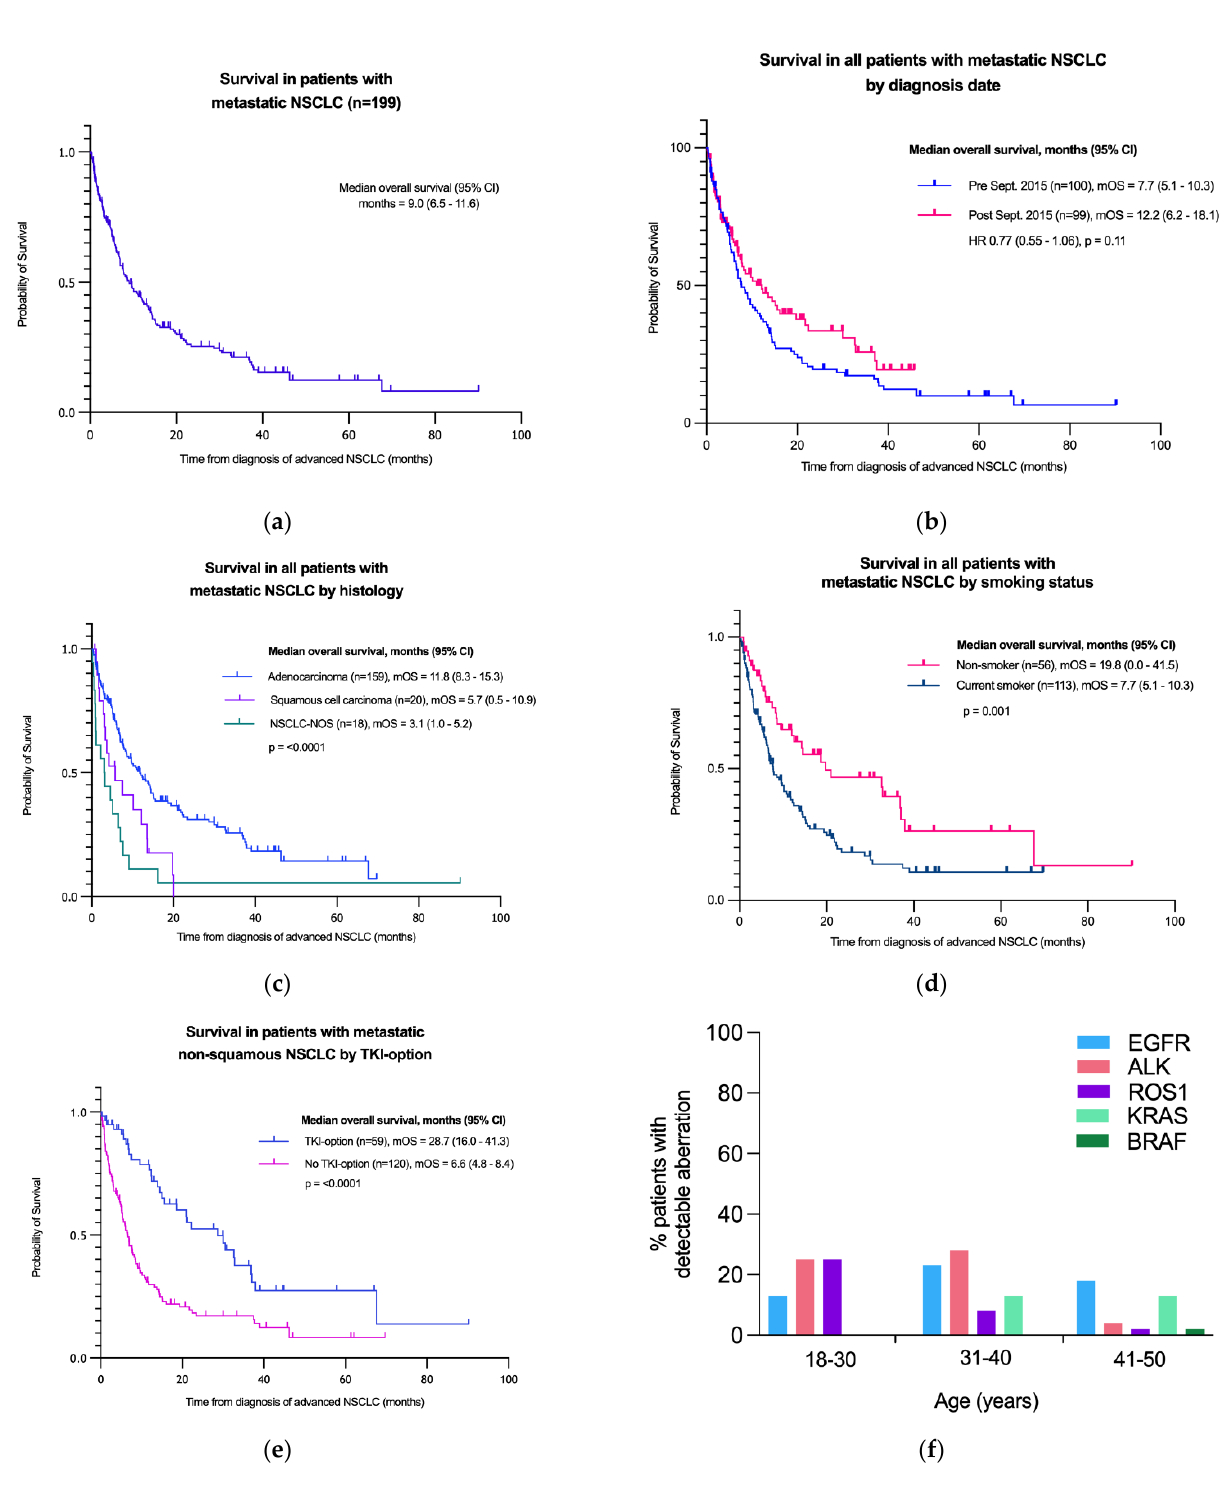
Figure 1. Survival analyses of ( a ) all metastatic NSCLC, ( b ) by diagnosis date, ( c ) by histopathology, ( d ) by smoking status and ( e ) by availability of TKI-option with ( f ) frequency of driver mutations by age